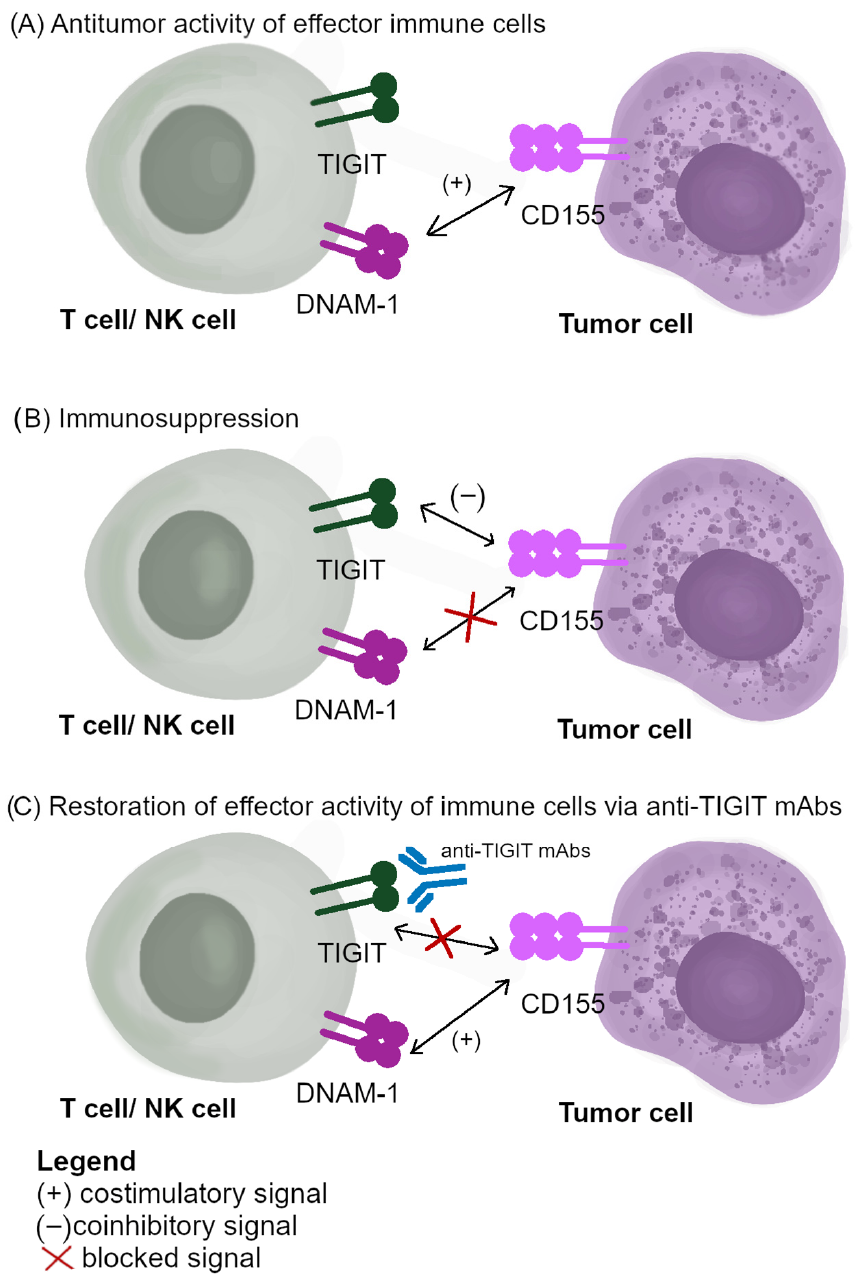
Figure 3. The role of TIGIT/CD155/DNAM-1 signaling in immunotherapies: ( A ) antitumor activity of effector immune cells; ( B ) immunosuppression; ( C ) the mode of action of anti-TIGIT mAbs.